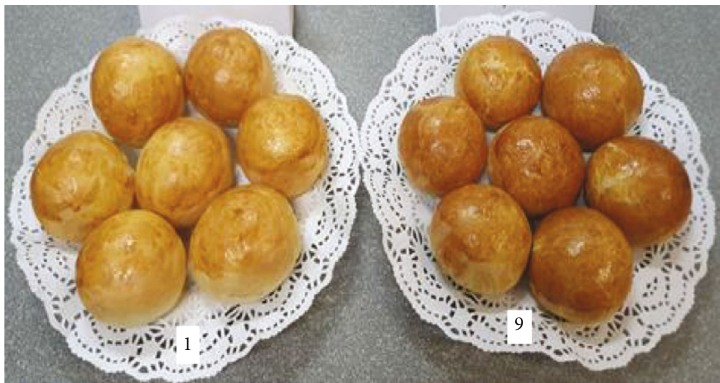
Figure 18: Sample no. 1: control sample and sample no. 9: the best